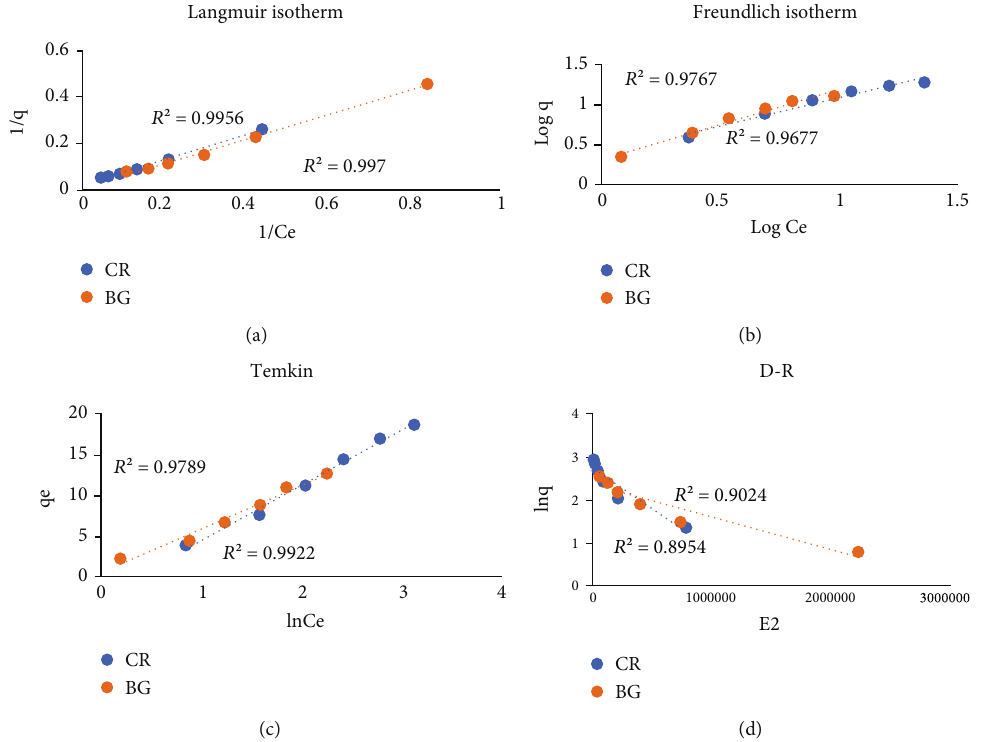
Figure 6: Adsorption isotherms. A comparative plot of CR and BG for adsorption on Brassica oleracea BO. (a) Langmuir isotherm, (b) Freundlich isotherm, (c) Temkin isotherm, and (d) Dubini-Radushkevich